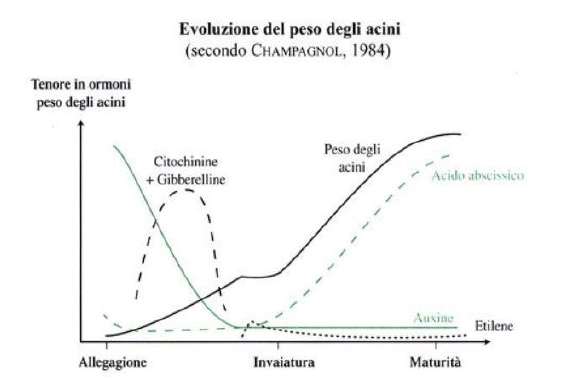
Figure 19. Growth of the